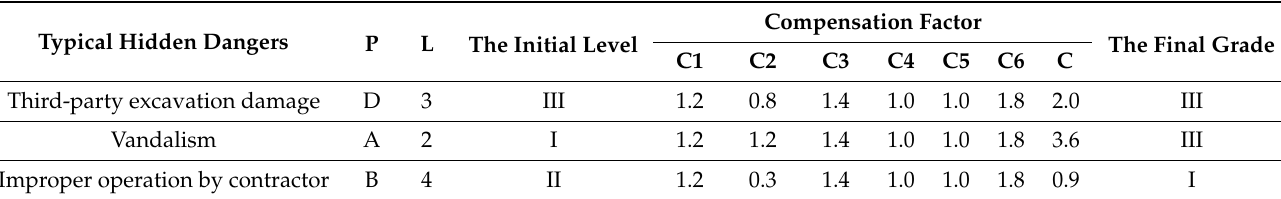
Table 12. Typical hidden danger